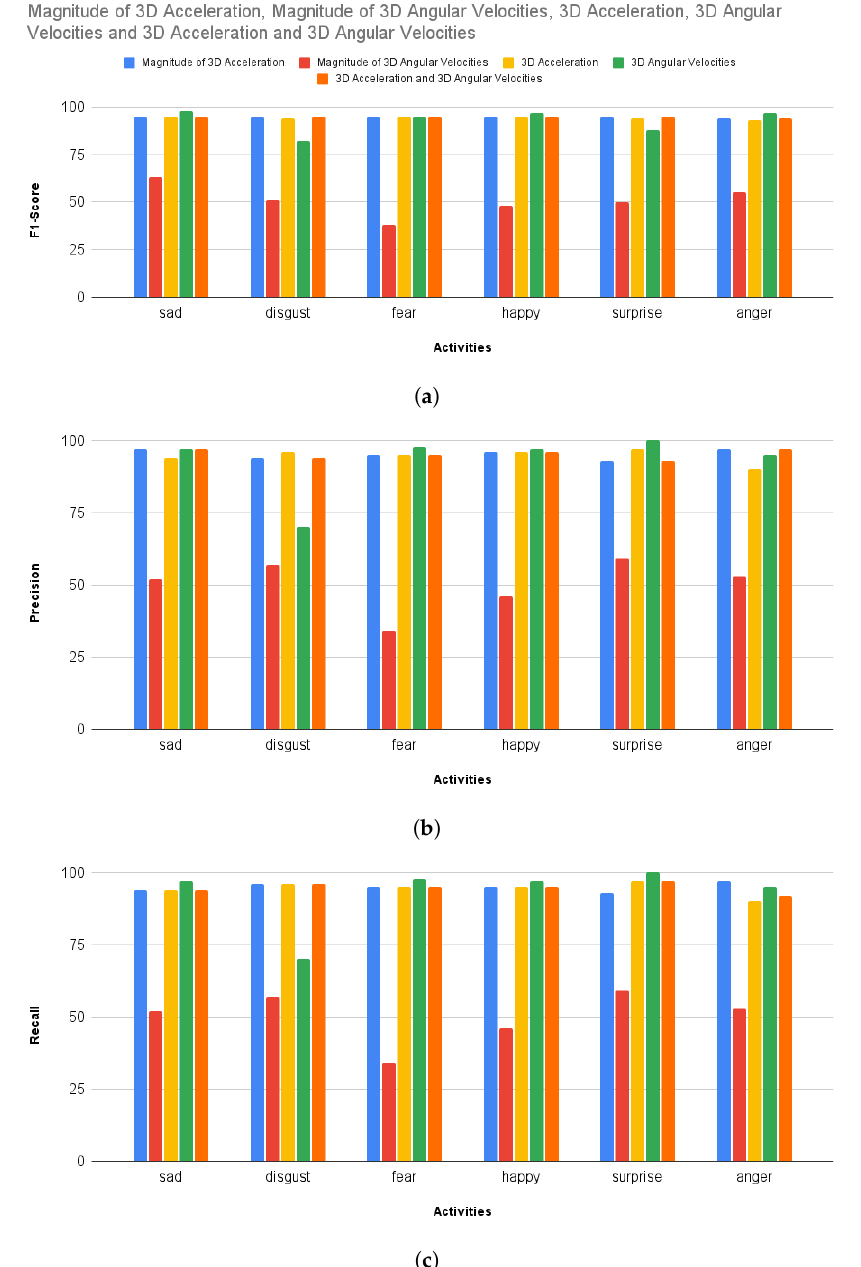
Figure 5. A comparison of F1-score, precision, and recall computed against different input signals (1D to 6D) is presented here. ( a ) F1-Score computed against different input sizes (1D–6D), ( b ) Precision computed against different input sizes (1D–6D), ( c ) Recall computed against different input sizes